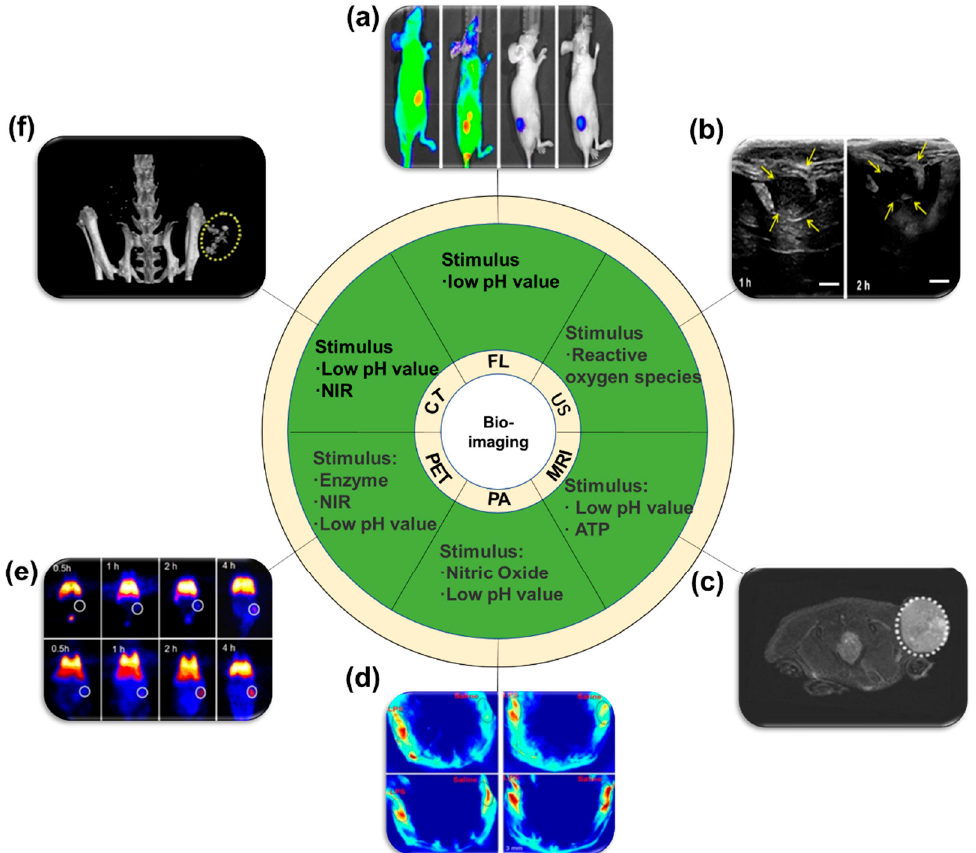
Figure 14. Stimulus-responsive systems for different bioimaging modalities. ( a ) Responsive to the acidic microenvironment in tumors, nanoprobes significantly enhanced tumor fluorescence imaging [265]. ( b ) ROS significantly enhanced the ultrasound signal [266]. ( c ) MR contrast could be enhanced in the tumor microenvironment by ATP/pH stimuli [267]. ( d ) PA signal could be significantly enhanced in tumor microenvironment by NO/pH stimulation [268]. ( e ) PET imaging enabled real-time monitoring of Enzyme/NIR/pH stimulus-responsive drug delivery systems [269]. ( f ) pH and NIR responsive system resulted in significant enhancement of CT contrast [270]. Reproduced with permission from the publishers of corresponding references.